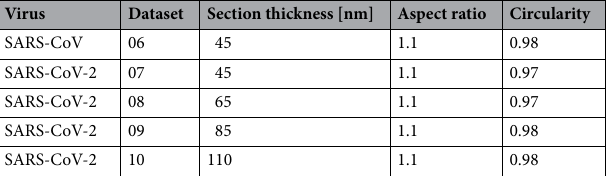
Table 2. Shape descriptors of virus particle profiles at different section